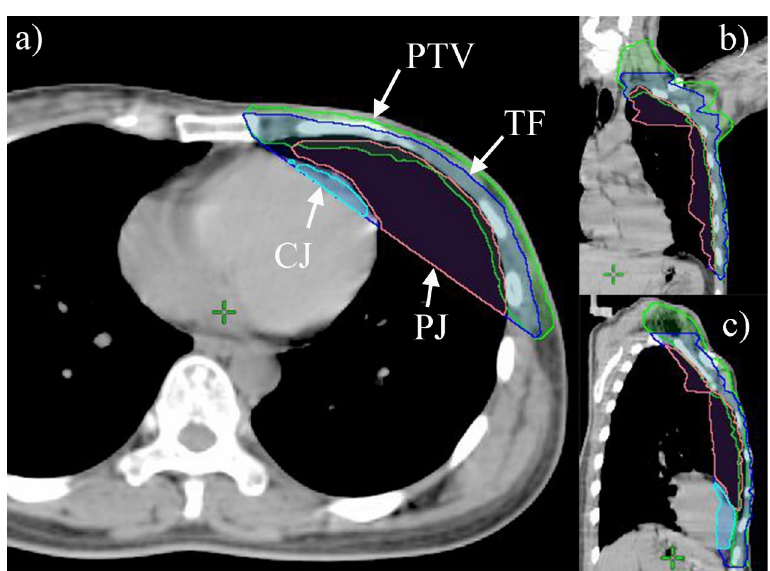
Fig 1. Geometric metrics displayed in axial (a), coronal (b) and sagittal (c) slices. The green, blue, cyan and pink contours were PTV, TF, CJ and PJ, respectively.